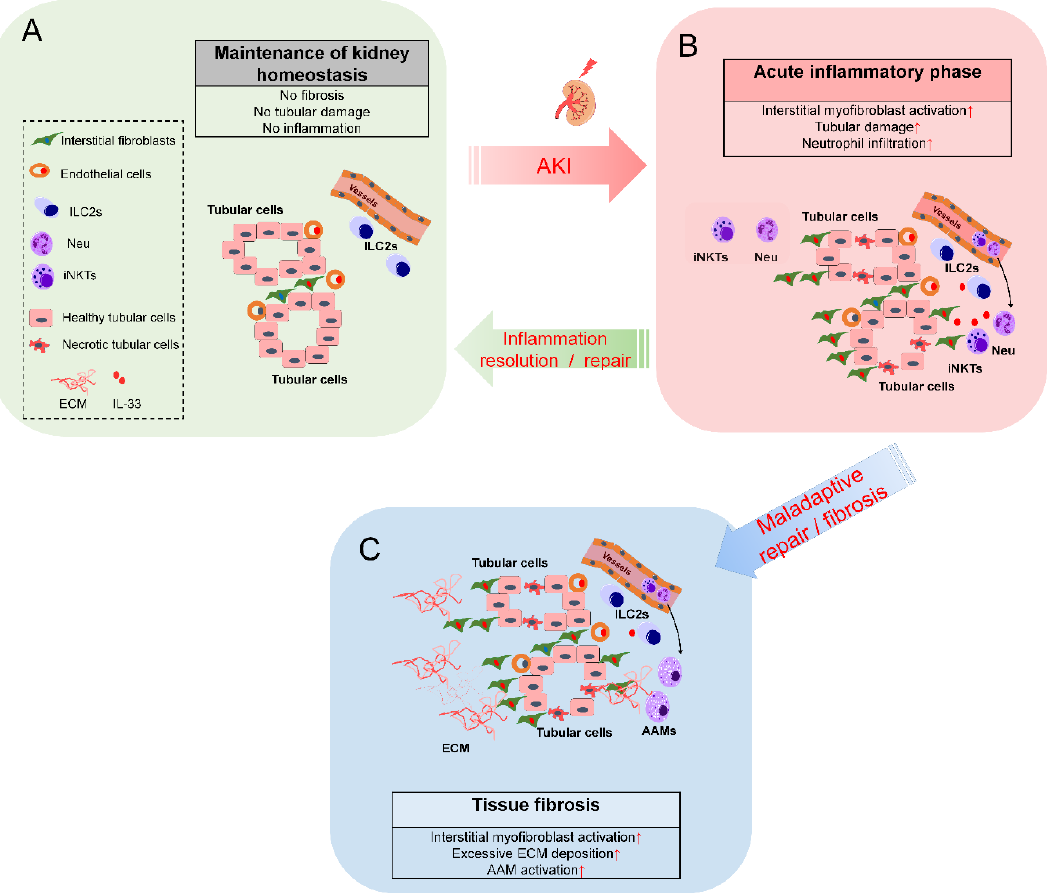
Figure 1. IL-33-mediated immunomodulatory networks in acute kidney injury. ( A ) IL-33 is expressed in the interstitial fibroblasts and endothelial cells in healthy kidney. ( B ) During the acute inflammatory phase of following kidney injury (0–24 h), IL-33 mediates the recruitment of immune cells, such as neutrophils and macrophages, and the amplification of inflammatory responses via iNKT cells. ( C ) During the recovery phase, IL-33 can mediate the activation of anti-inflammatory responses via ILC2s, alternatively activated macrophages (AAMs), and regulatory T-cells (Tregs). However, maladaptive repair or excessive interstitial myofibroblast activation may result in excessive extracellular matrix (ECM) deposition. Long-term treatment with high-dose exogenous IL-33 may promote tissue fibrosis if the analysis is performed at later stages of disease onset following kidney injury.